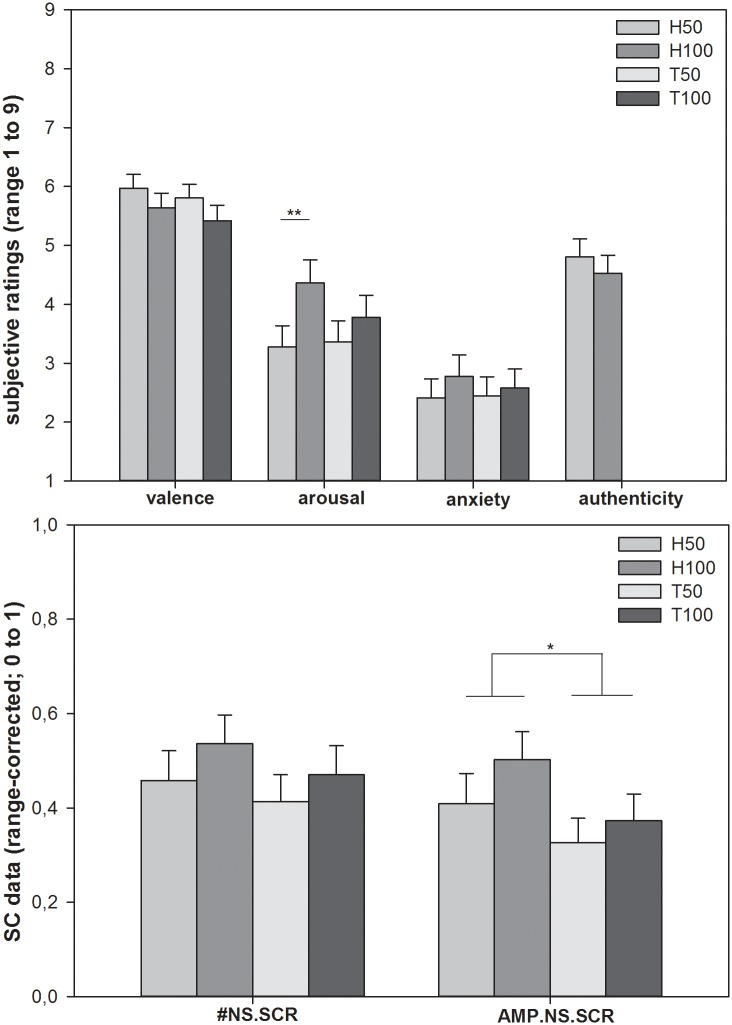
Behavioural data, illustrated separately for each experimental condition (H50, H100, T50, T100).Upper half: Subjective ratings on the dimensions arousal, valence, anxiety, and authenticity. Higher values indicate higher arousal, but positive valence. Lower half: Skin conductance data (range-corrected values). Error bars indicate the standard error of mean (SEM). #NS.SCR: mean number of non-stimulus specific skin conductance reactions; AMP.NS.SCR: mean amplitude of non-stimulus specific skin conductance reactions. * p < 0.05. ** p < 0.01